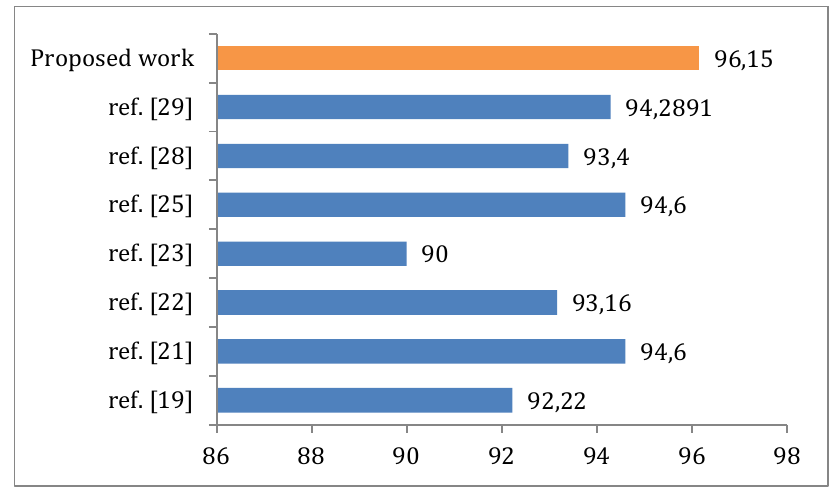
Figure 6. Bar graphs for comparison of algorithms based one evaluation metrics